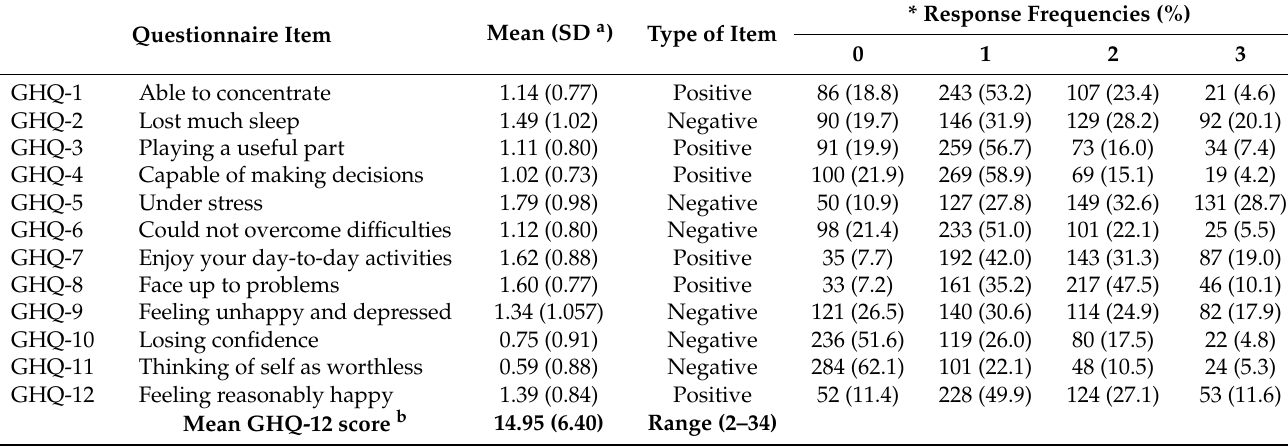
Figure 1. Proportion of psychological well-being among the participants. Table 2. Distribution of GHQ-12 items and summary scores (N = 457).